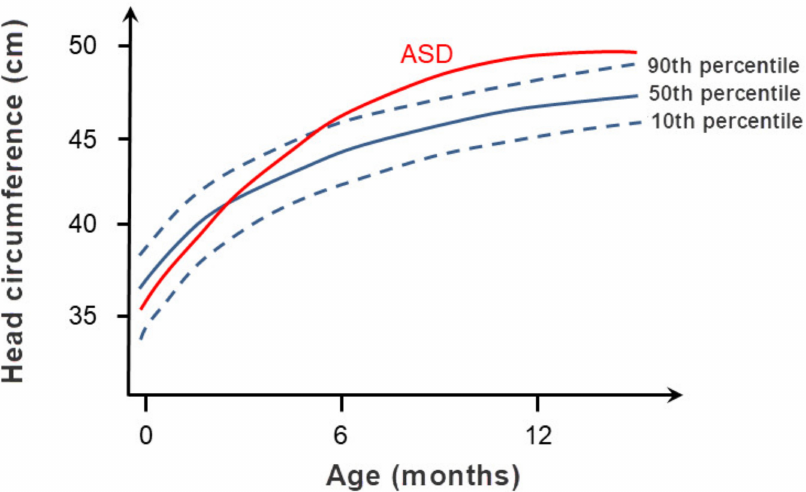
Figure 9. Early excessive growth of head circumference in children with autism spectrum disorders (ASD). After reduced head circumference at birth, during the first year of life in children with ASD there is a pathologically increased growth in head circumference and the total size of the cerebellum and cerebellum. The graph is based on Courchesne et al. (2003)